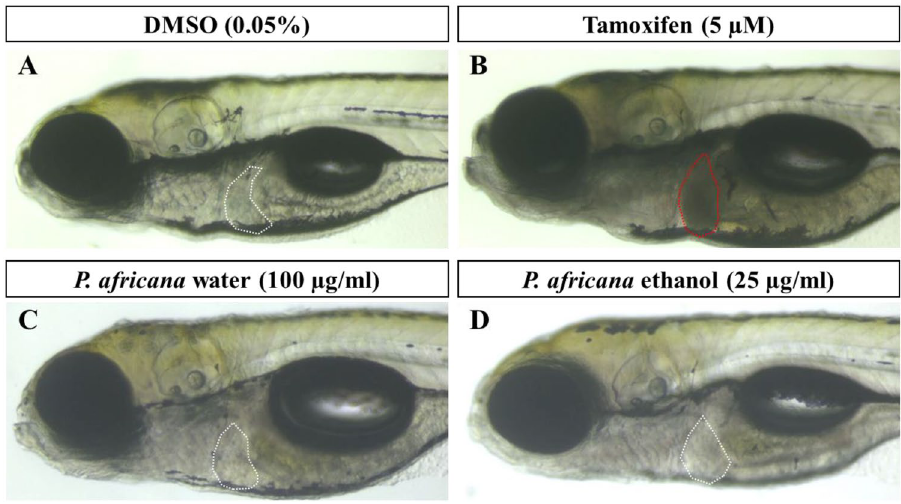
Figure 4. Hepatotoxicity assay in zebrafish larvae at 120 hpf. ( A ) DMSO as a negative control did not induce hepatotoxicity. ( B ) Tamoxifen induced liver cell death (shown by red arrow). ( C ) 100 µg/ml P. africana water did not induce hepatotoxicity. ( D ) 25 µg/ml P. africana ethanol did not induce